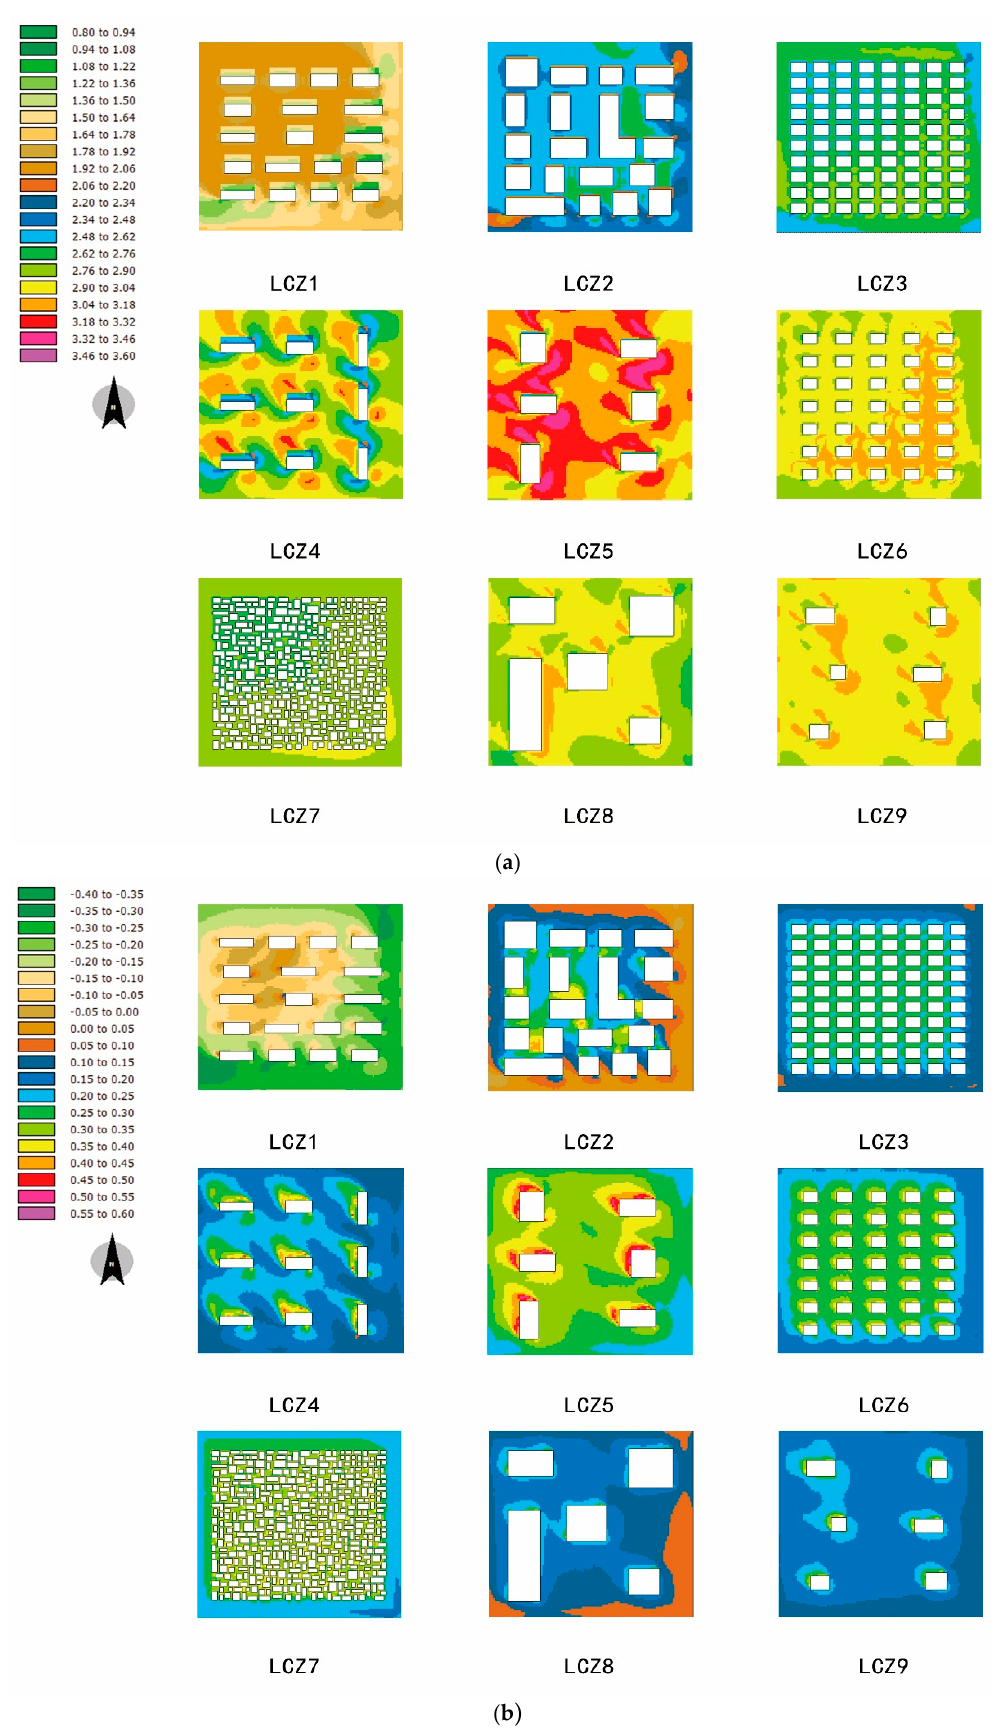
Figure 6. Distribution of predicted mean vote (PMV) at 12:00 ( a ) and 21:00 ( b ) for all the nine models.